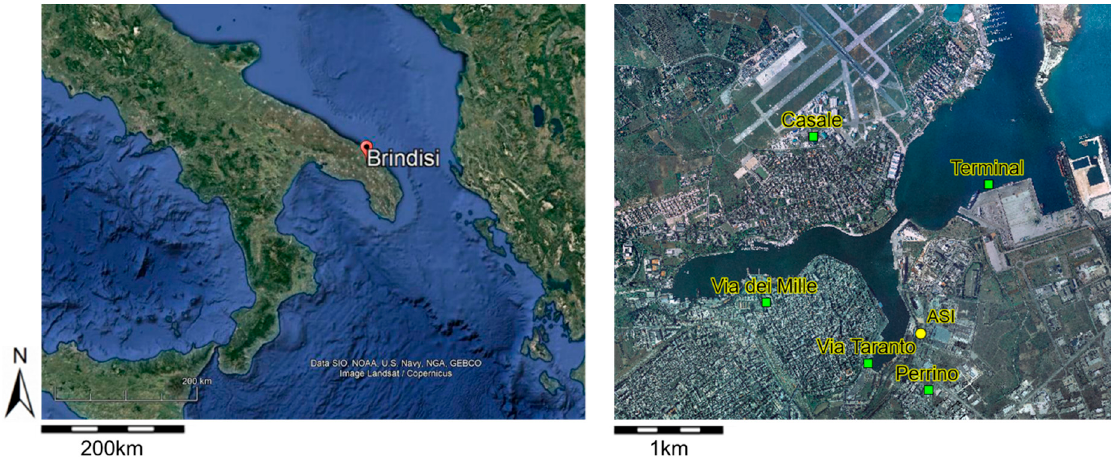
Figure 1. Map of the southern part of Italy showing the position of Brindisi ( left ) and satellite image showing the experimental site in yellow (ASI) and the monitoring stations managed by ARPA-Puglia ( right ).